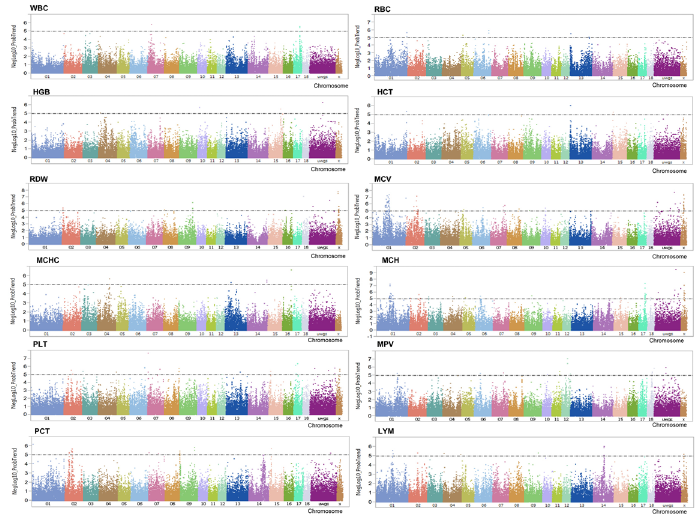
Fig 1. Manhattan plots displaying the genome-wide association based on single-markers analysis with haematological traits in German Landrace. Black lines indicate the significance threshold corresponding to negative log10 (NegLog10) >